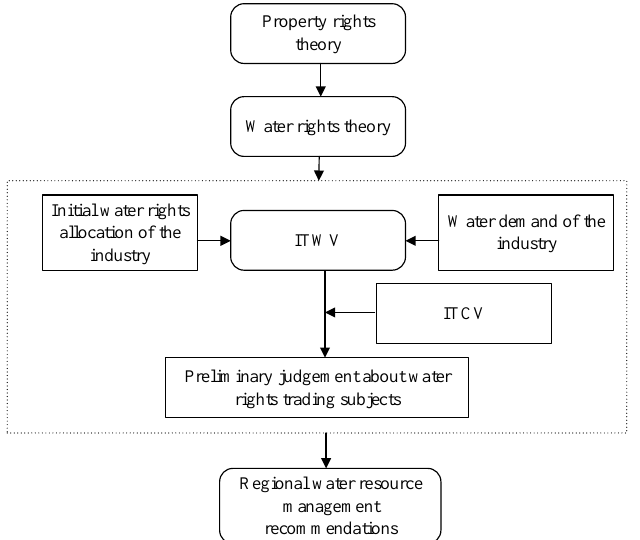
Figure 1. The schematic diagram of the research structure. (ITWV is short for tradable water volumes of industry. ITCV is short for tradable control volumes of industry.).